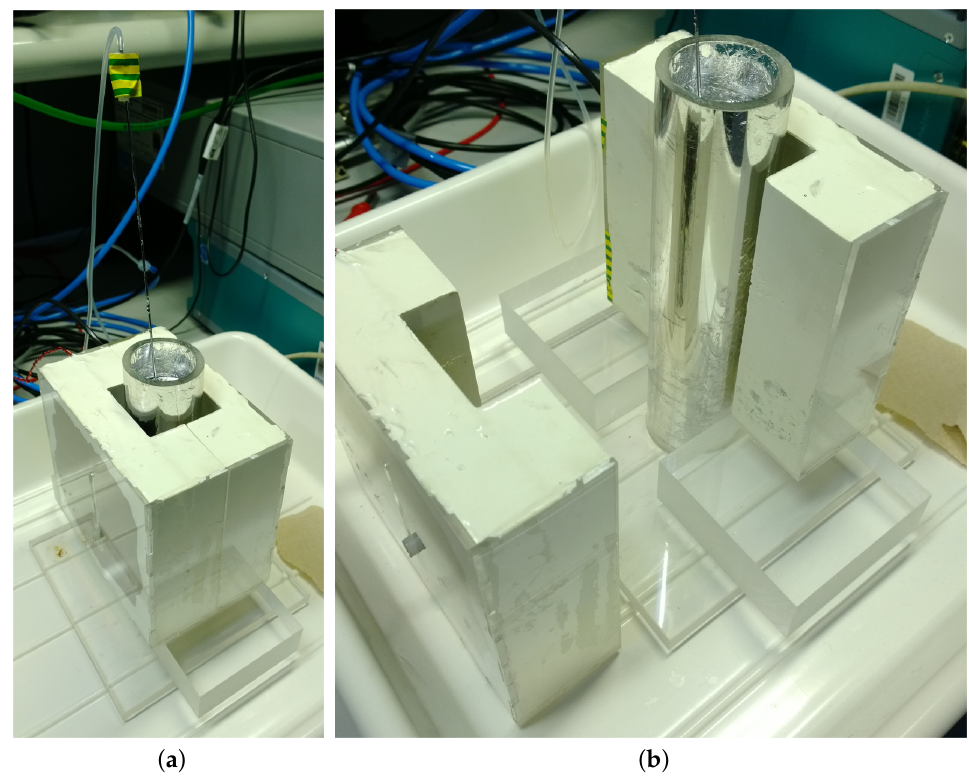
Figure 4. Photograph of the cylindrical setup with the vessel filled with GaInSn, the excitation coil